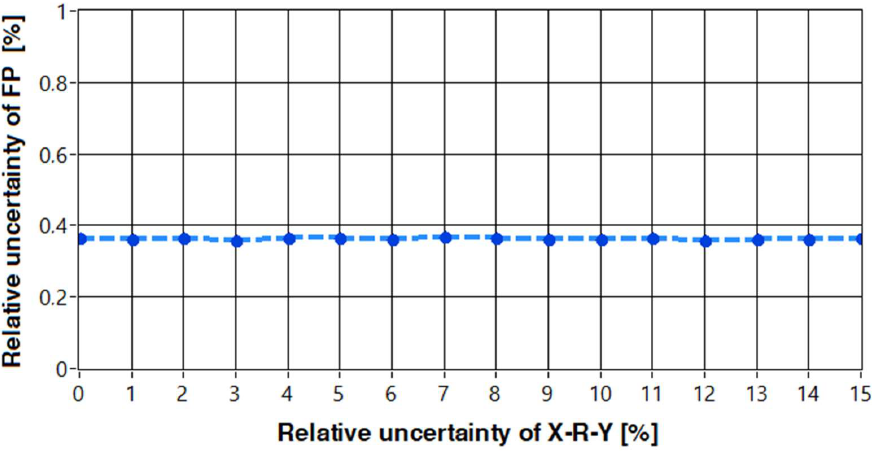
Figure 21. Relative uncertainty in the calculated active power flow of branch 1 of the “MTL3” line in dependence of the line parameter uncertainties.